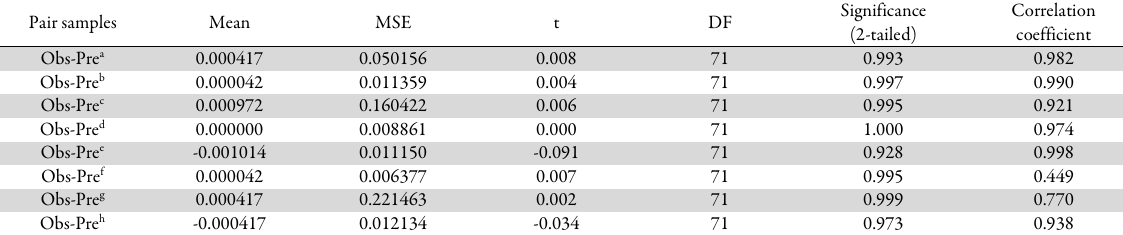
Table 1. Pair wise test comparing observed and predicted values of process outputs Pair samples Mean Obs-Pre a